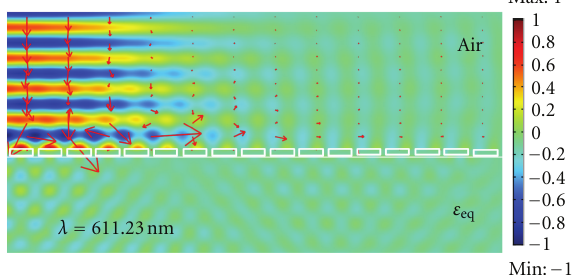
Figure 10: Magnetic field component H z at λ = 611.23 nm of the equivalent system with the parameters in Figure 9 applied to the case of θ = 10 ◦ . Exploiting the even symmetry of the structure, the left side of the magnetic field is the mirrored replica of this plot. Red arrows indicate the direction of the Poynting vector. In this case the source has a Gaussian-shaped spatial